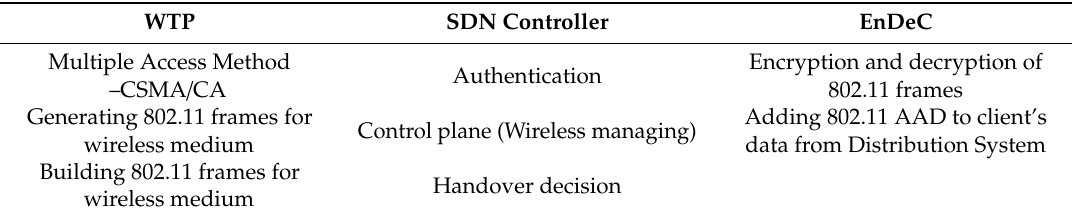
Table 1. Distribution of the 802.11